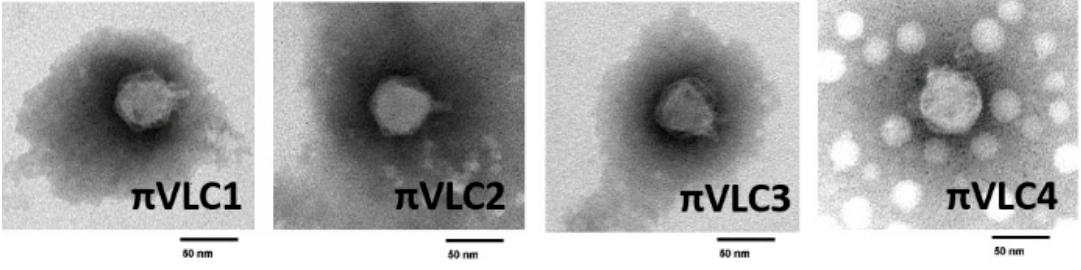
Figure 3. Transmission electron micrographs of the four novel K. pneumoniae phages. Scale bar: 50 nm.